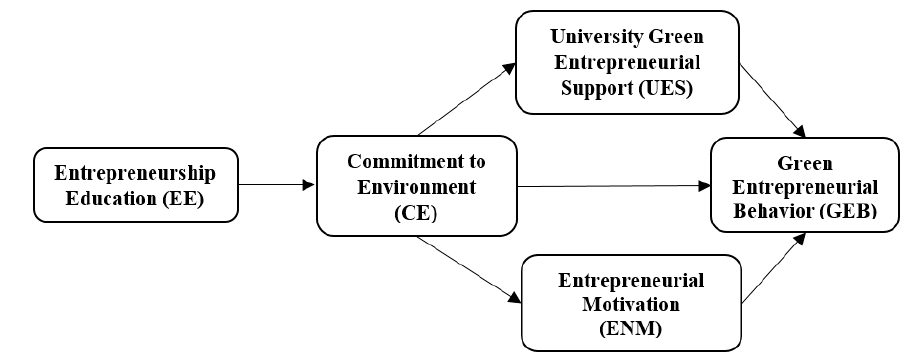
Figure 1. Conceptual Model